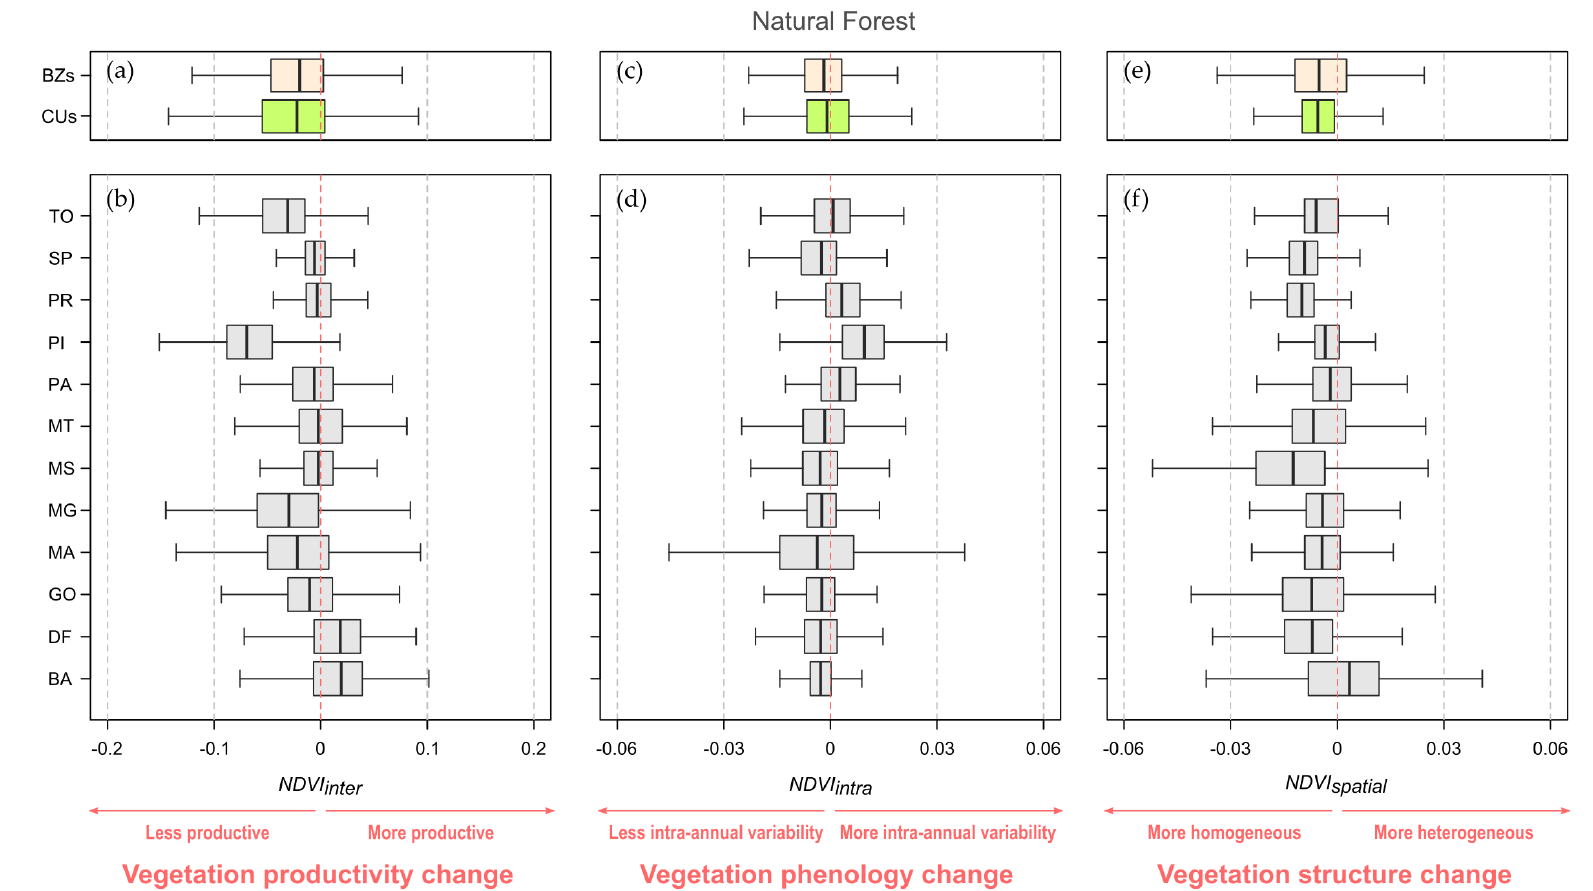
Figure 7. Boxplots of the landscape metrics’ values of the cells belonging to the ‘Natural Forest’ category : (a) 𝑁𝐷𝑉𝐼 𝑖𝑛𝑡𝑒𝑟 in the buffer zones (BZs) and conservation units (CUs); (b) 𝑁𝐷𝑉𝐼 𝑖𝑛𝑡𝑒𝑟 in each state; (c) 𝑁𝐷𝑉𝐼 𝑖𝑛𝑡𝑟𝑎 in the BZs and CUs; (d) 𝑁𝐷𝑉𝐼 𝑖𝑛𝑡𝑟𝑎 in each state; (e) 𝑁𝐷𝑉𝐼 𝑠𝑝𝑎𝑡𝑖𝑎𝑙 in the BZs and CUs; (f) 𝑁𝐷𝑉𝐼 𝑠𝑝𝑎𝑡𝑖𝑎𝑙 in each state. Number of 250 m resolution (6.25 ha) cells located inside the 61 conservation units = 209,714 and in their buffer zones = 382,556. Number of cells in each Brazilian state with n > 0: Tocantins (TO, 34,905), São Paulo (SP, 4,296), Paraná (PR, 220), Piauí (PI, 21,057), Pará (PA, 285), Mato Grosso (MT, 22,749), Mato Grosso do Sul (MS, 28,982), Minas Gerais (MG, 73,836), Maranhão (MA, 39,514), Goiás (GO, 22,063), Distrito Federal (DF, 2,305), Bahia (BA, 982).